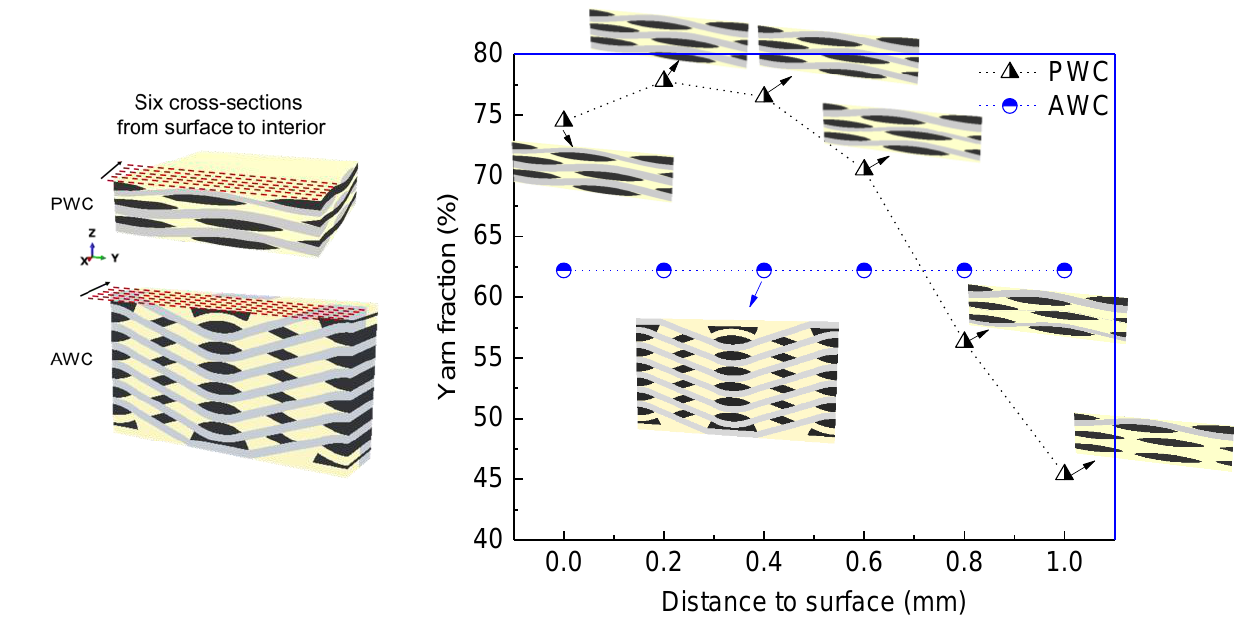
Figure 11. Variations of yarn volume fraction in six cross sections form the surface to interior.